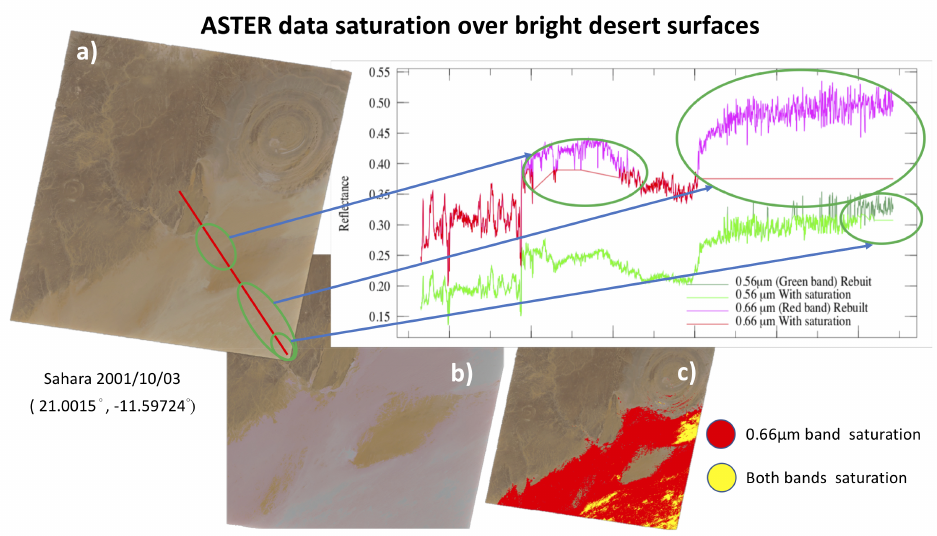
Figure 5. Visualization of the saturation corrections over desert areas: ( a ) final true color composite; ( b ) original saturated granule; ( c ) mask of the saturated areas (in red for the 0.66µm band and in yellow for both 0.56 and 0.66µm